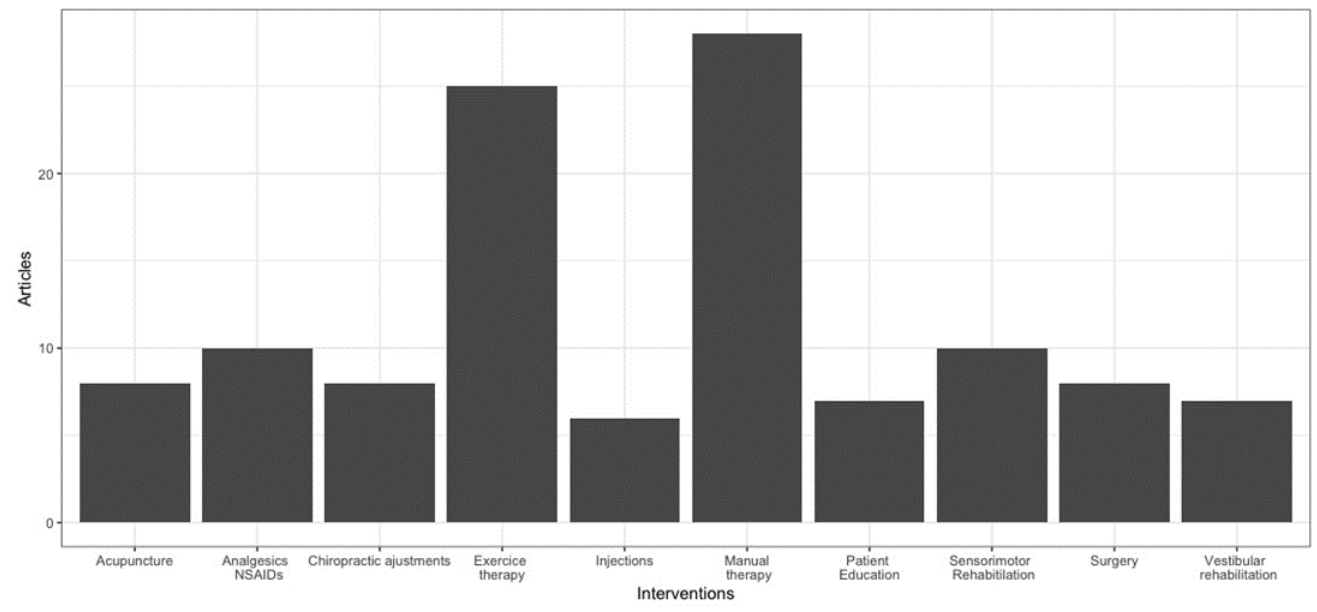
Figure 7. Interventions on PCGD in the literature.